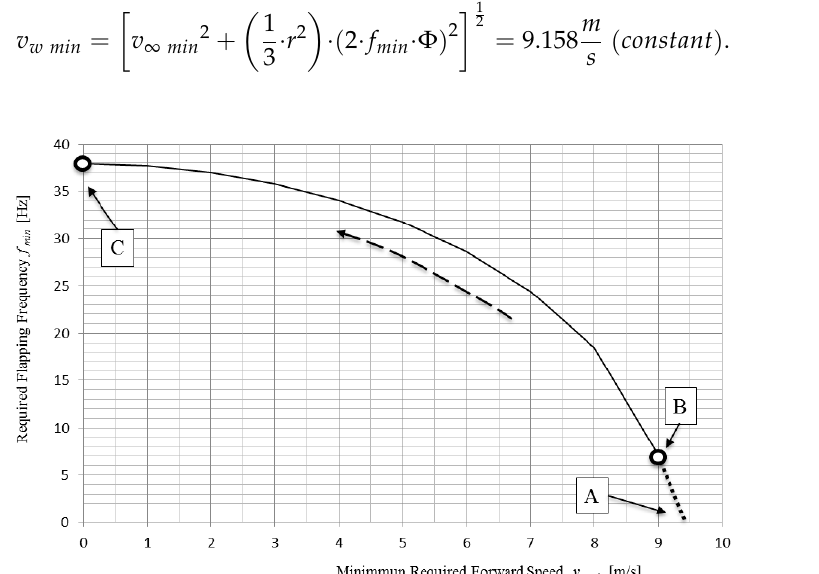
Figure 15. The effect of forward velocity v ∞ on flapping frequency f for a constant wing velocity v w as the wing generates a lift L equal to the weight W of the protobird.